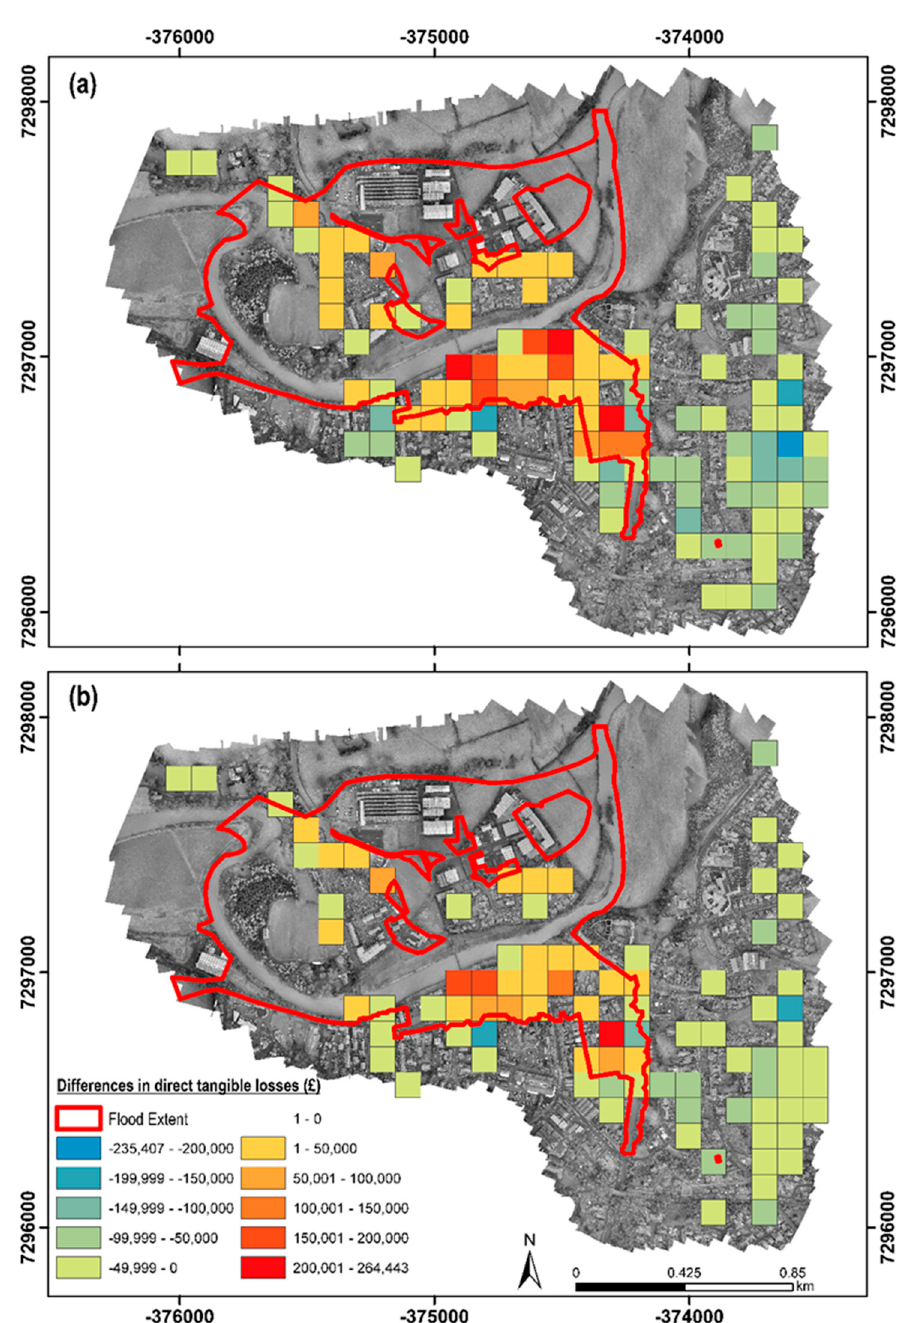
Figure 8. Difference between the UAV and the classic loss adjustment approaches in direct tangible losses (£) when considering damage to property for affected households after the Desmond floods (5–6 December 2015) for Cockermouth (Cumbria, UK) ( a ) with no resistance measures in place and ( b ) with resistance measures being operational. The methodology used for the estimation of the direct tangible losses was based on [31,32]. The losses (without VAT or other indirect taxes) are in GBP at 2016/17 prices. Negative values indicate larger losses associated with the UAV approach.